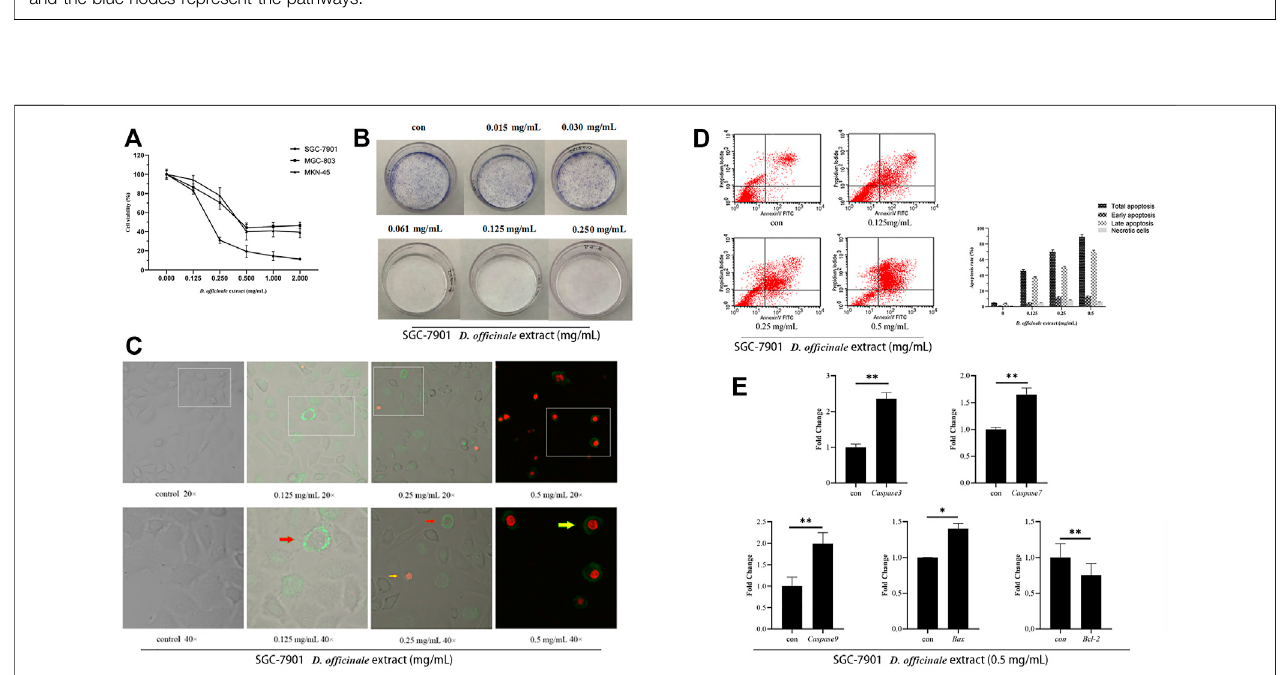
FIGURE 8 | Component – target – pathway network of the D. of fi cinale extract. The green nodes represent the component, and the red nodes represent the targets and the blue nodes represent the pathways.